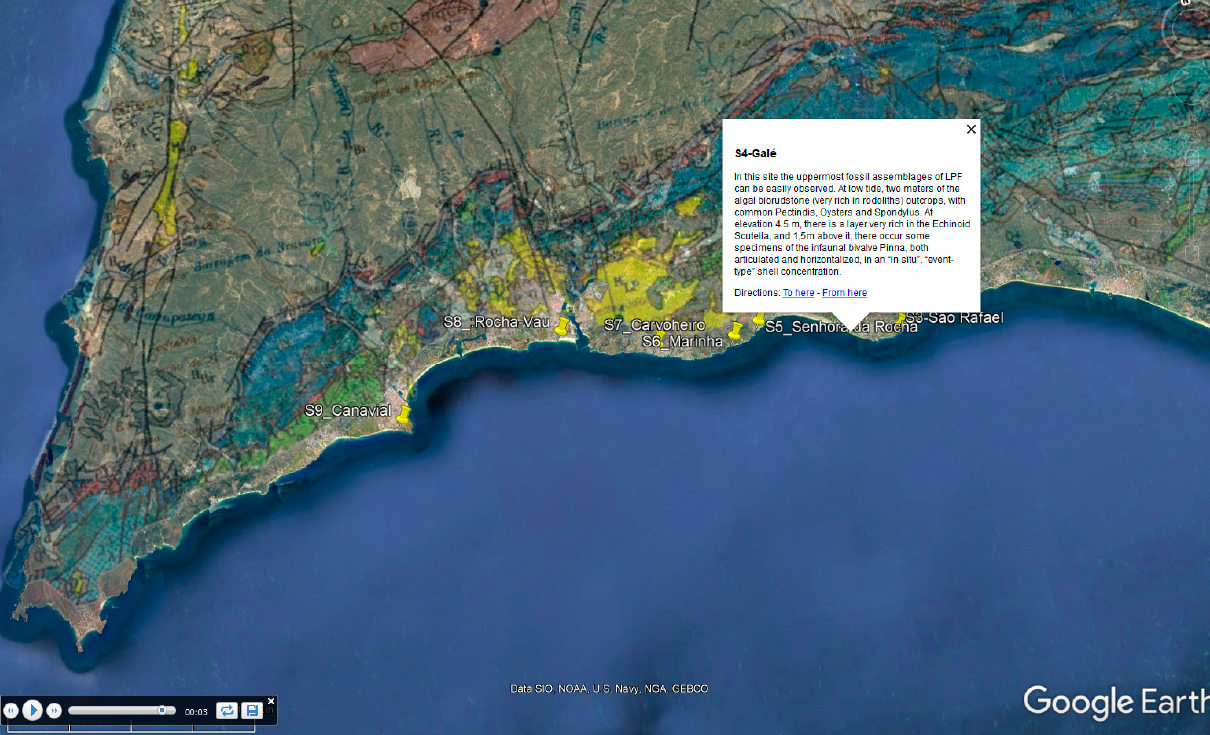
Figure 8. Capture showing the route generated automatically between geosite Olhos de Agua and Gale. The possibility of choosing to realize the route by car, bus, bicycle or by walking can be observed in the left part of the image. It also shows the time and the indications as we move. In the lower part of the table of contents, we observe the loaded thematic layers on which the studied placemarks are superimposed. Profile routes with elevation and slope are included in the itinerary. The free Google Earth platform allows the recording of video (Figure 9) for the itin- eraries in which all the resources can be implemented (photographs and diagrams, etc.)